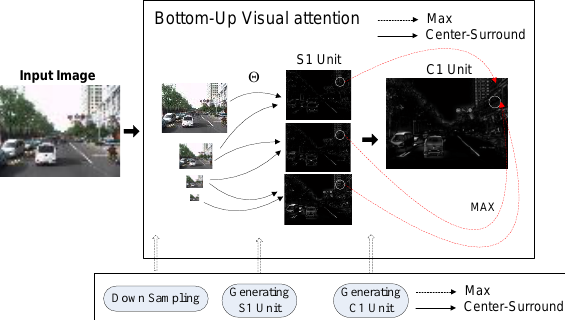
Fig.3. Flowchart of image attention